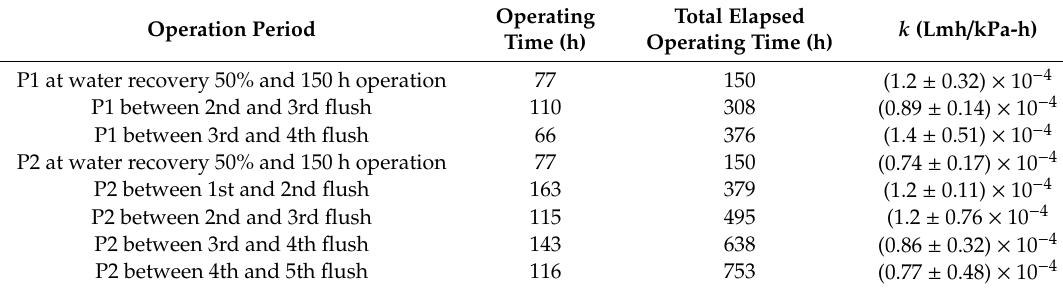
Table 3. k values of di ff erent operation periods (P1: Phase 1, P2: Phase